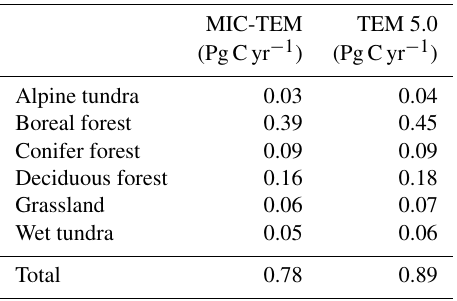
Table 2. Partitioning of average annual net ecosystem production (as PgC per year) for six vegetation types during the 20th